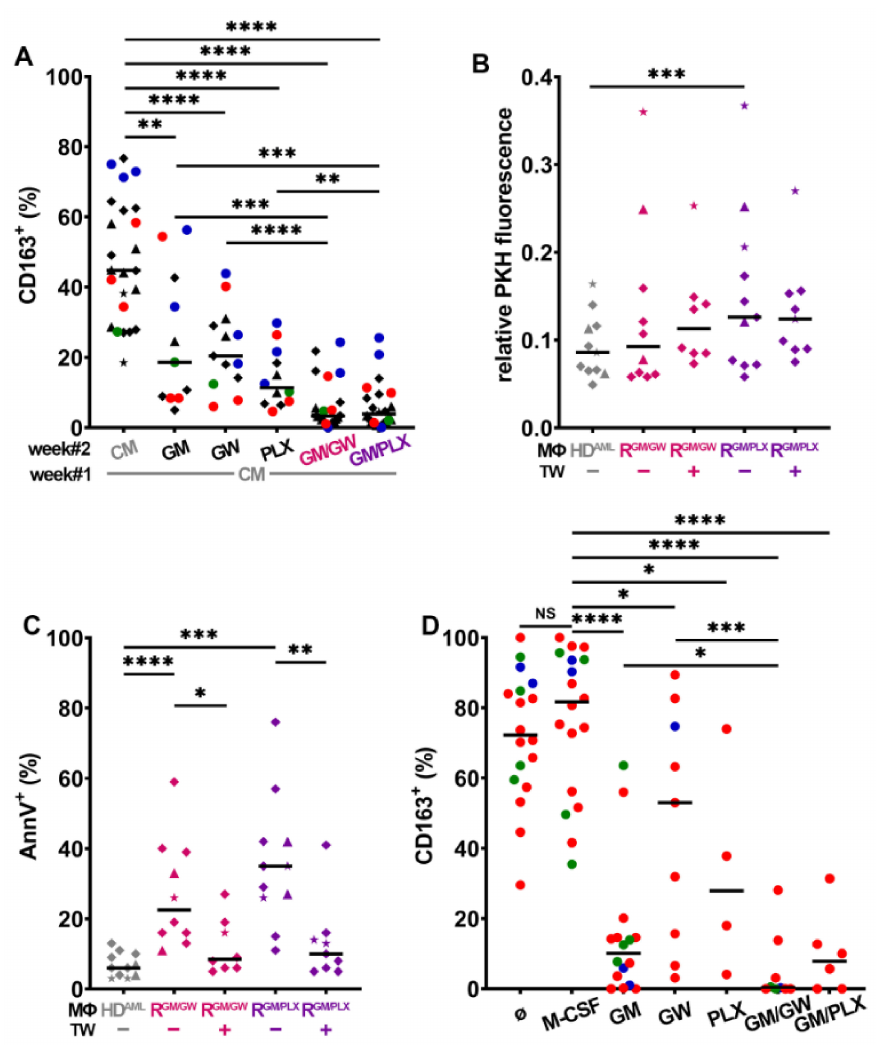
Figure 4. Reprogrammed AML macrophages induce myeloblast apoptosis. ( A ) After one week of stimulation in CM from U937 ( (cid:7) ), HL-60 ( (cid:70) ), NB4 ( (cid:78) ), or primary patient blasts (colored dots), HD AML -M Φ s were either left in the same CM or reoriented in PM with in- dicated supplements for one additional week and CD163 expression was analyzed by FC. n = 11–24. ( B ) Myeloblast proliferation and ( C ) apoptosis induced after 4 days of co-culture on HD AML -M Φ s. (cid:70) = HL-60, (cid:78) = NB4, and (cid:7) = U937. ( D ) Primary BM patient samples color-coded according to genetic risk were cultured for 7 days in PM + indicated supple- ments and analyzed by FC. (GM/GW = GM-CSF + GW2580, GM/PLX = GM-CSF + PLX3397). * p < 0.05, ** p < 0.01, *** p < 0.001, and **** p < 0.0001 (using M-W test except between paired groups that were compared with WMP